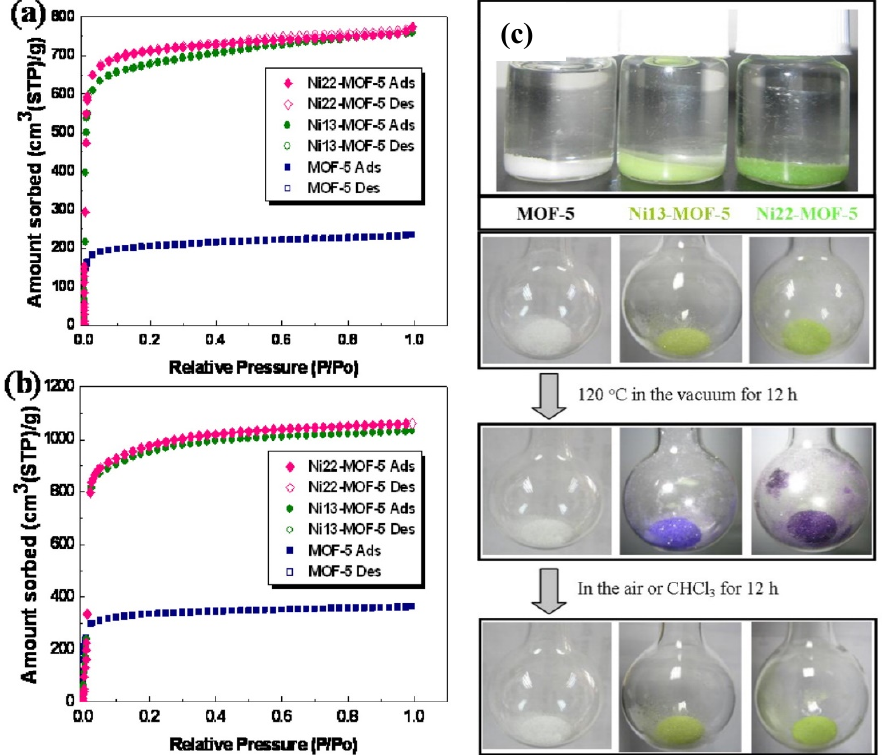
Figure 7. ( a ) N 2 and ( b ) Ar sorption isotherms of MOF-5 and Ni-doped MOF-5 with varying amounts of Ni; ( c ) color change of MOF-5 and Ni-doped MOF-5 under vacuum and re-exposure to air of CHCl 3 . Adapted with permission from [84]; Published by American Chemical Society, 2012.